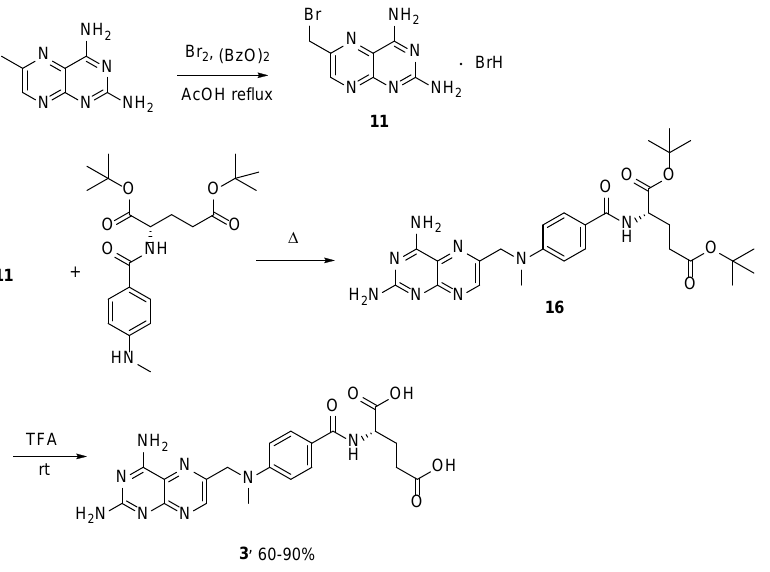
Scheme 6. Synthesis of MTX from 4-oxoderivative of MTX (methopterin hydrate) ( 15 ).